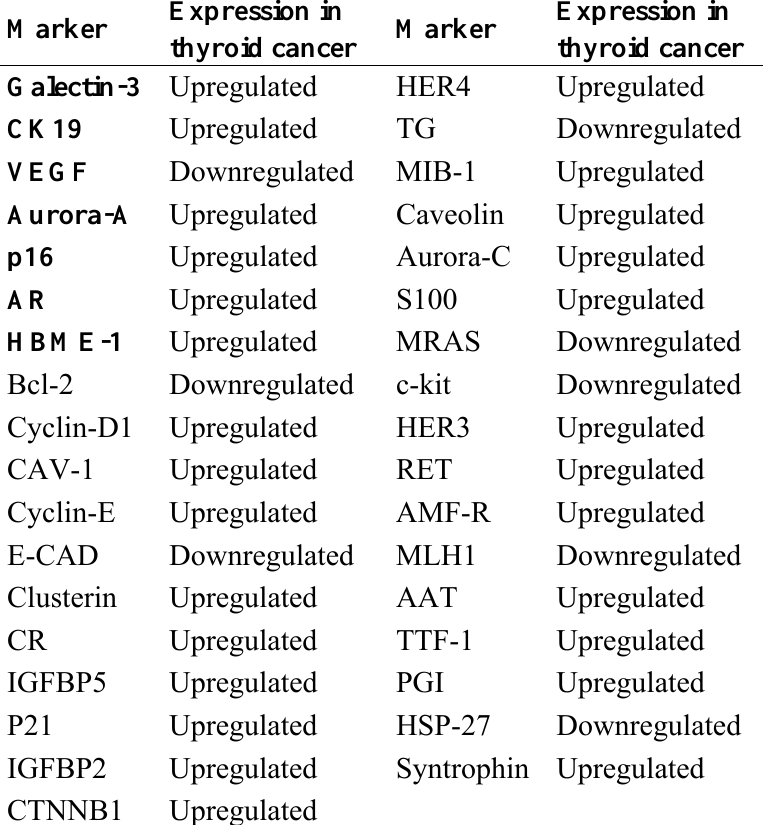
Table 2. Significant IHC Markers in Differentiated Thyroid